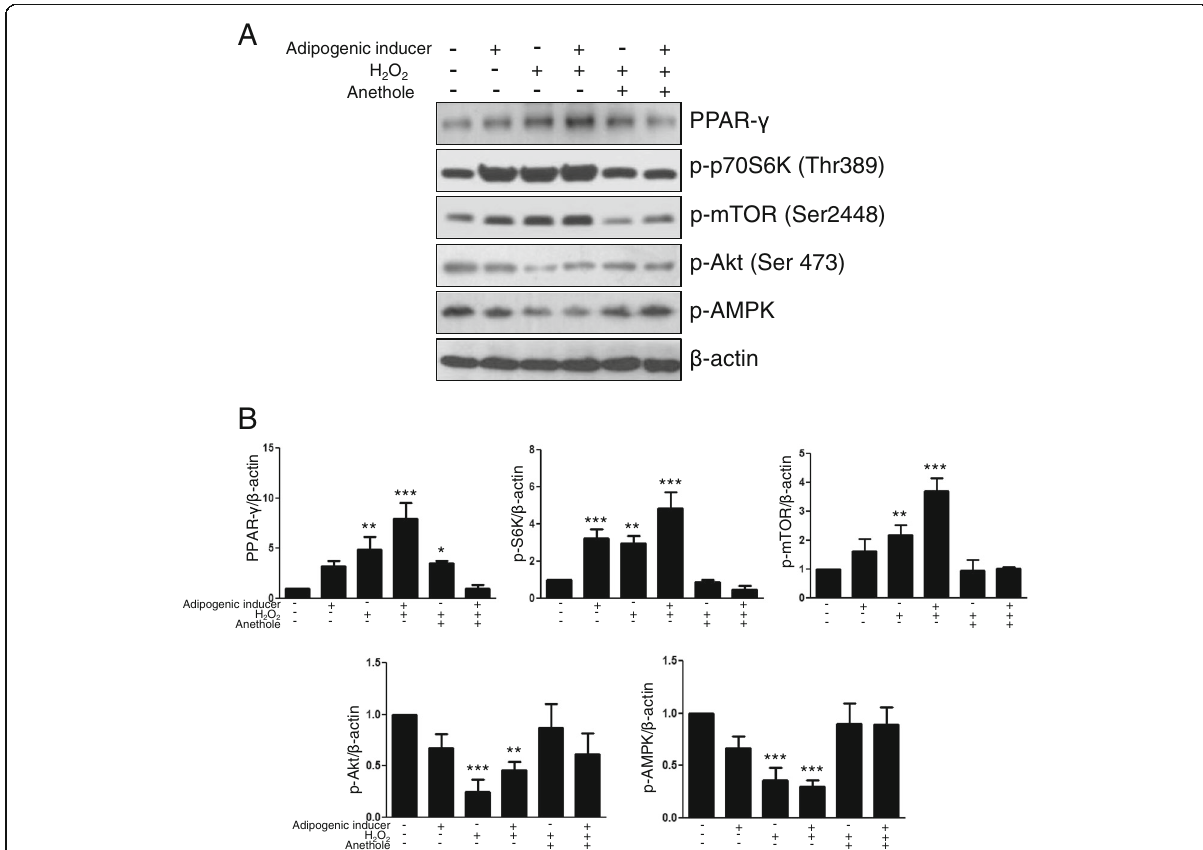
Fig. 4 Western blot analysis of theffect of anethole on transcriptional factors with excessive ROS during adipogenic differentiation. a 2 mM H 2 O 2 was added for 30 min on the first day of adipogenic differentiation. After exposure to H 2 O 2 , hMSCs were incubated with adipogenic media for 2 weeks. Whole cell lysates were prepared equally at day 14 as described in Fig. 3. b Each protein expression was exhibited in the same manner as described in Fig. 3b. Each experiment was repeated three times and the values are presented as mean ± S.D. ** p < 0.05, and *** p <